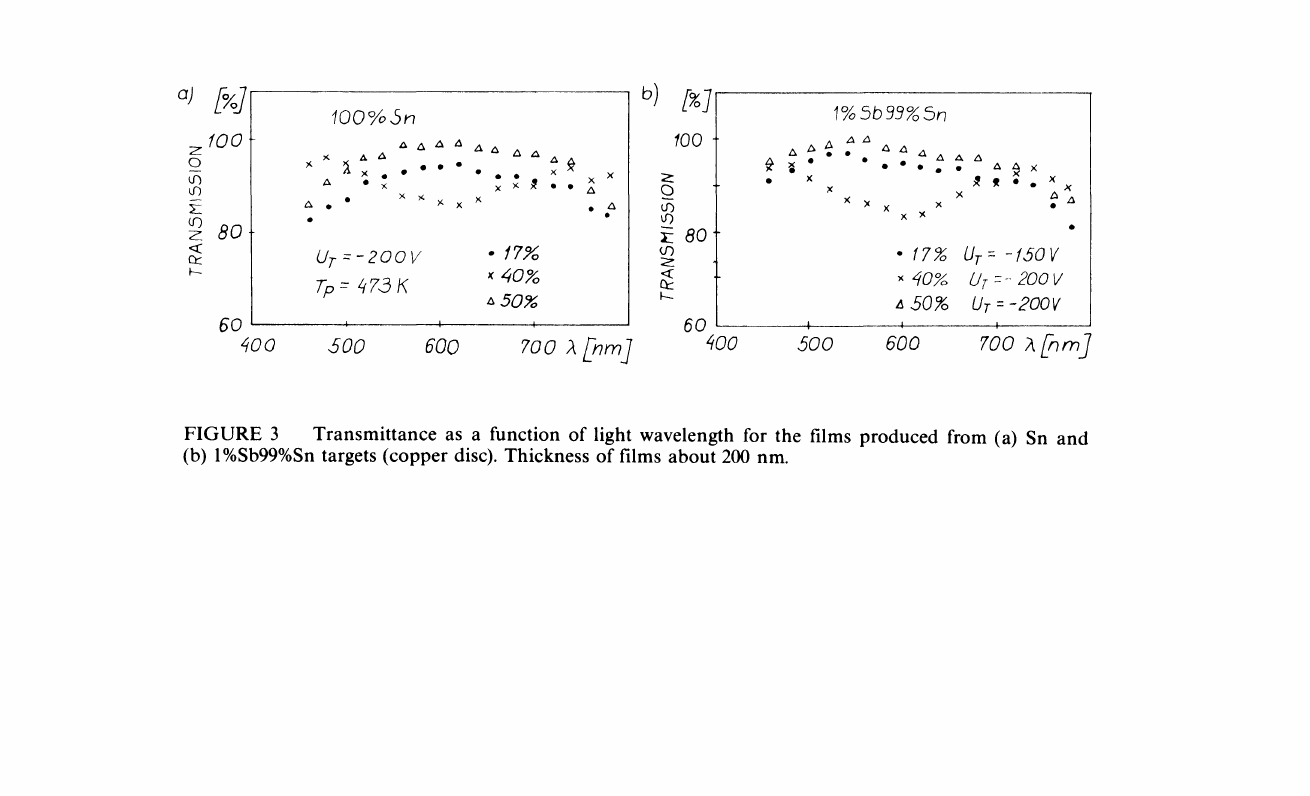
Transmittance as a function of light wavelength for the films produced from (a) Sn and (b) Sb99 Sn targets (copper disc). Thickness of films about 200